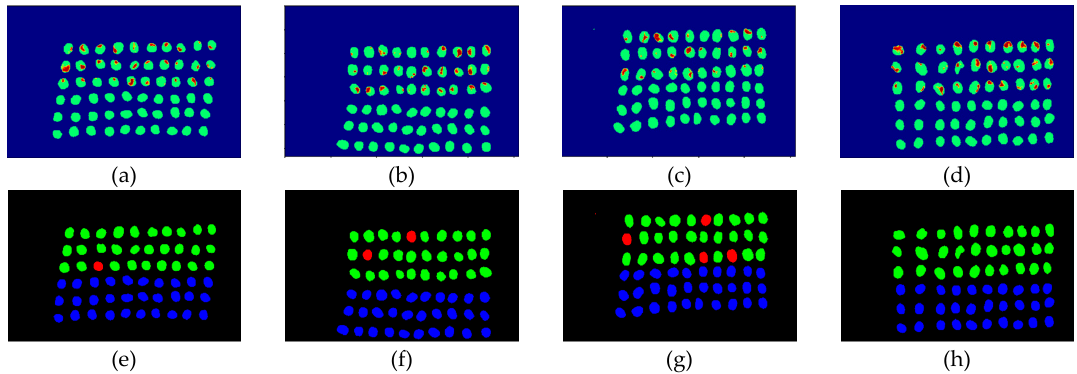
Figure 25. Results of green coffee beans CNN+SB_CTBS three bands, ( a–d ) CNN classification results, ( e–h ) final visual images.